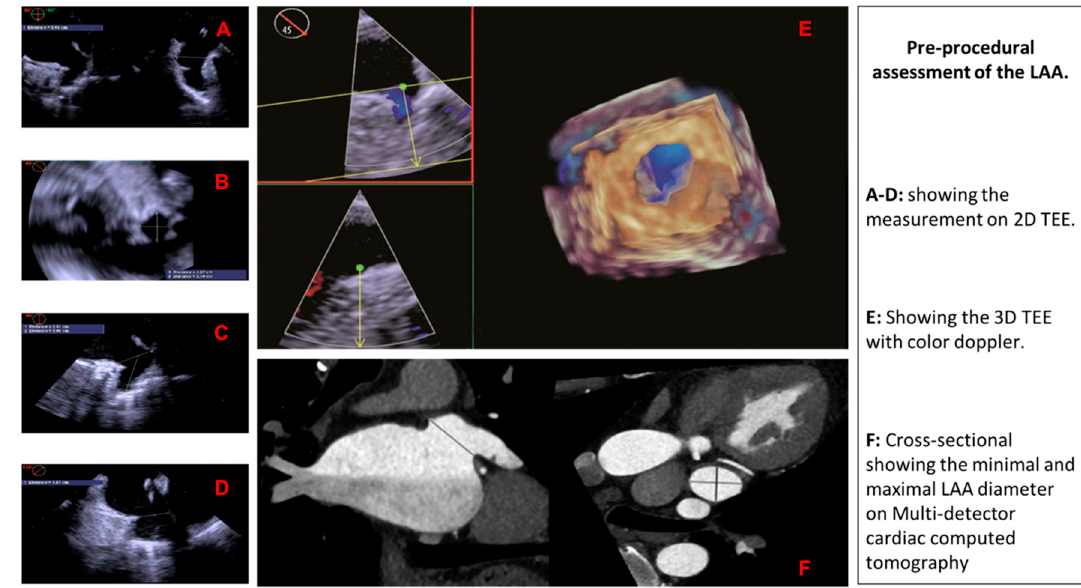
Figure 3. Pre-procedural assessment of the LAA using different imaging modalities.